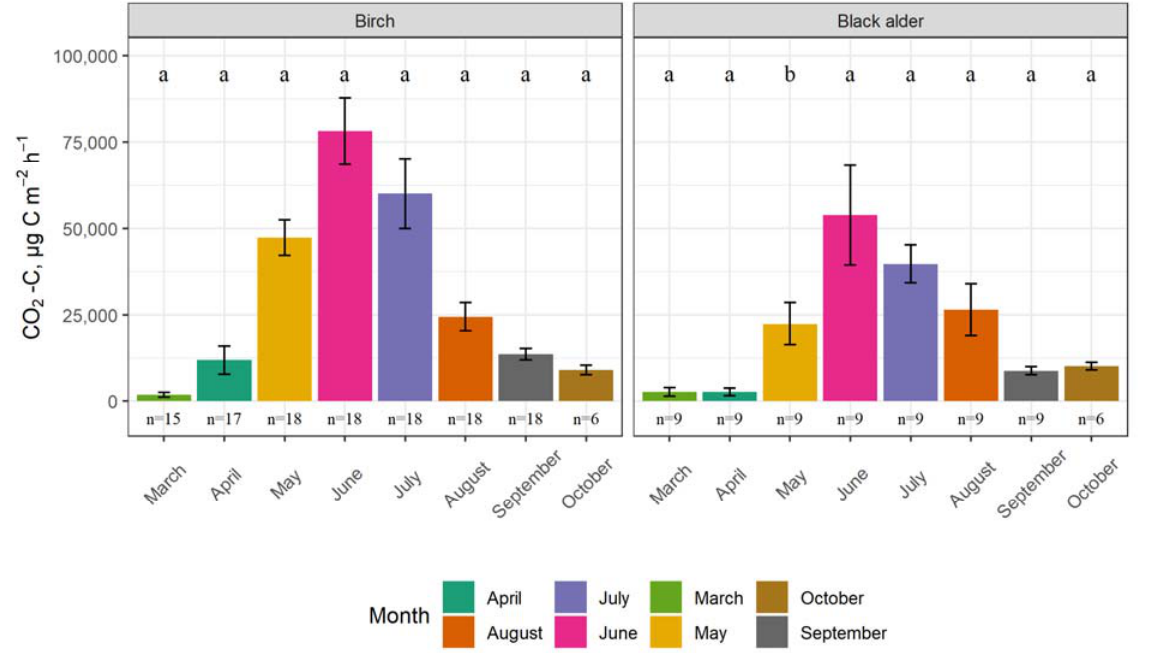
Figure 4. Average monthly CO 2 fluxes from silver birch and black alder stems (mean value ± S.E.). Numbers below the bars (n) show number of measurements in each month. Different lowercase letters show statistically significant differences ( p < 0.05, Wilcoxon rank sum exact test) between tree species within the same month.